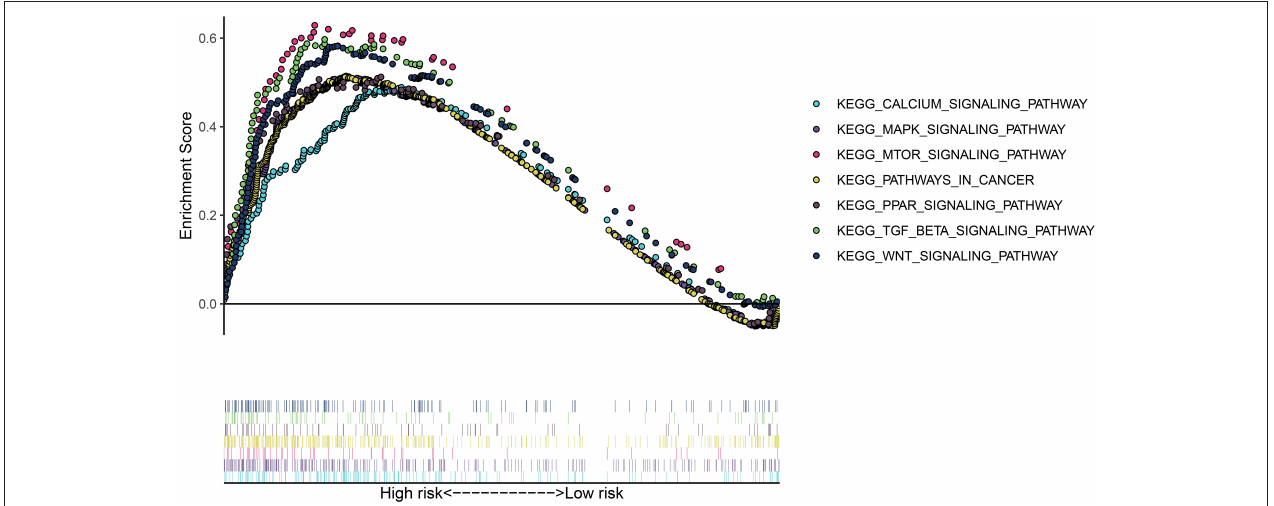
FIGURE 5 | GSEA revealed the signaling pathways enriched in the high-risk group.